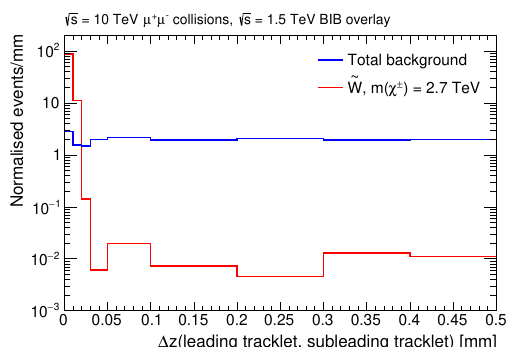
√ s = 10 TeV muon collision events with